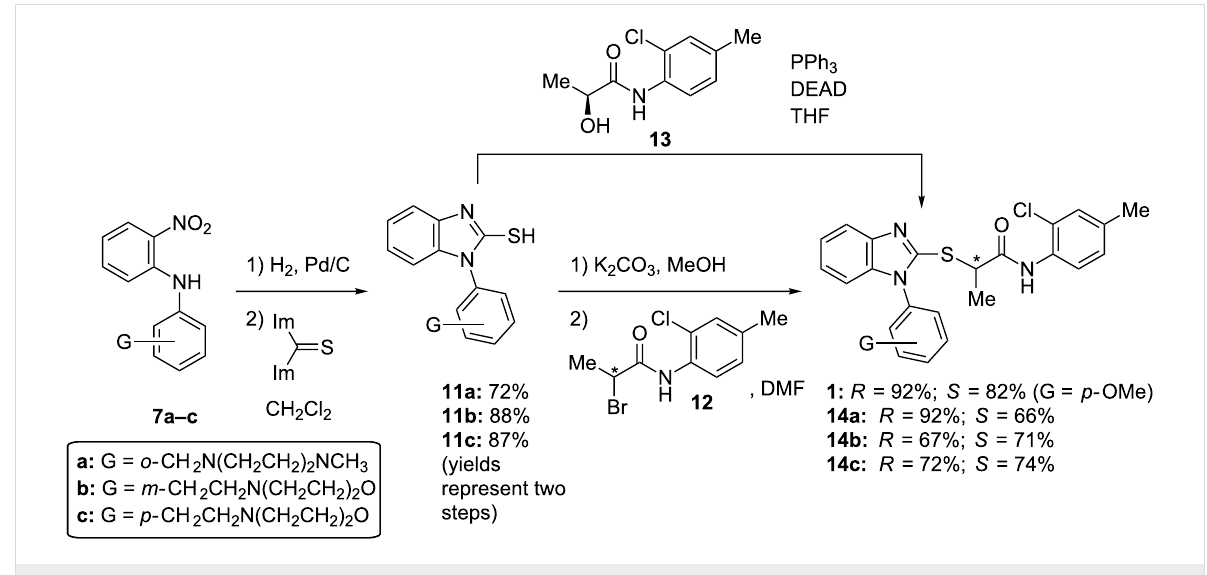
Scheme 3: Asymmetric synthesis of ( R )- and ( S )-isomers by using two different